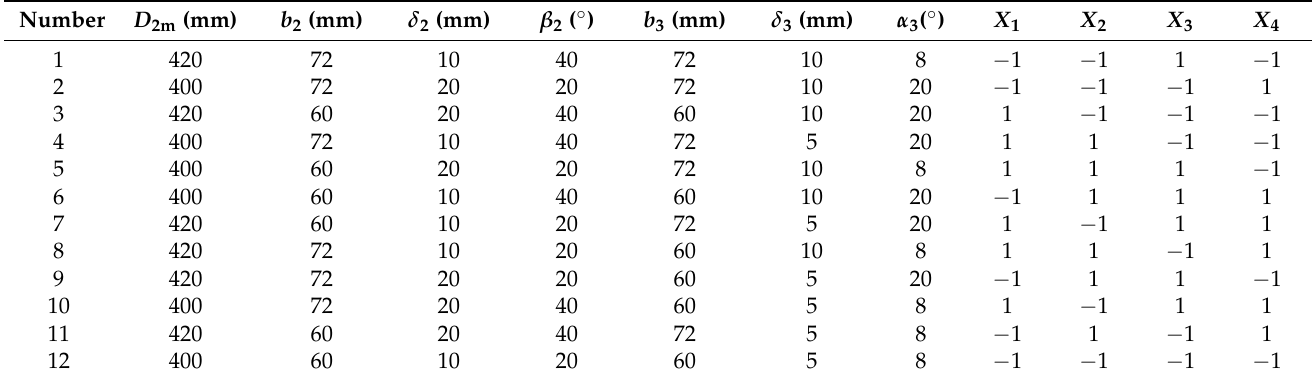
Table 5. Plackett–Burman experimental design scheme.